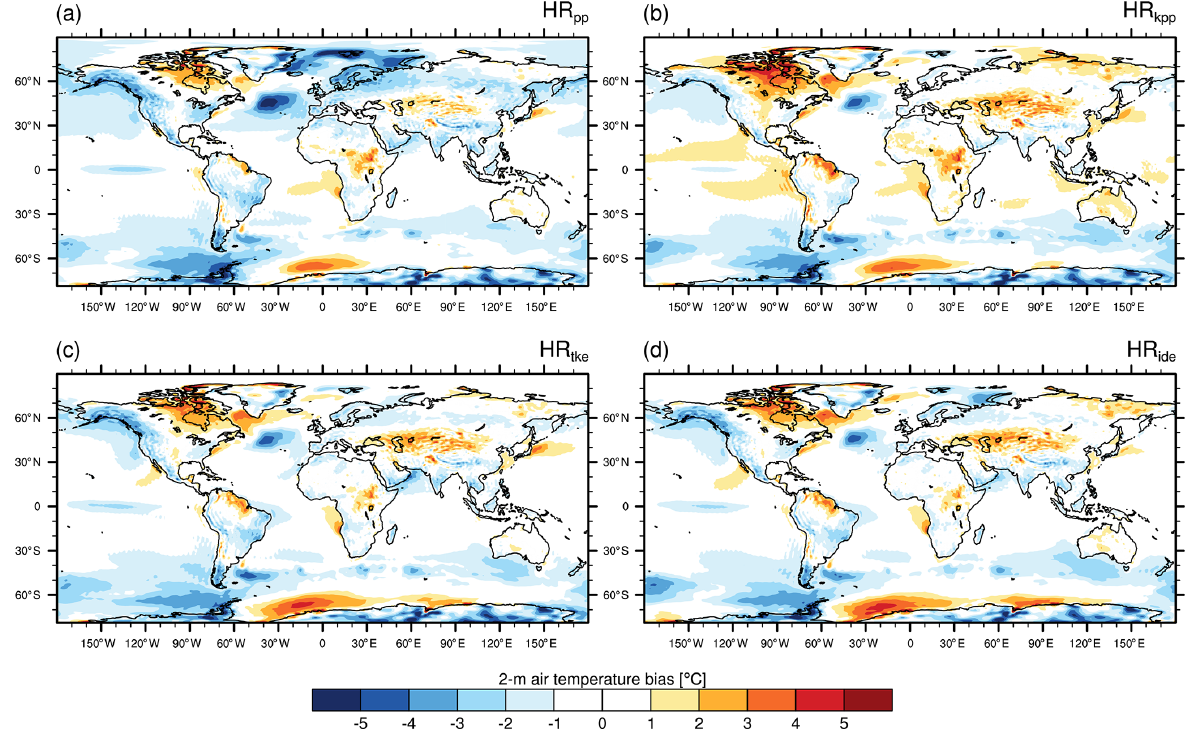
Figure 17. Time-averaged 2m air temperature (SAT) bias (MPI-ESM1.2 minus EN4) for (a) HR pp , (b) HR kpp , (c) HR tke , and (d) HR ide